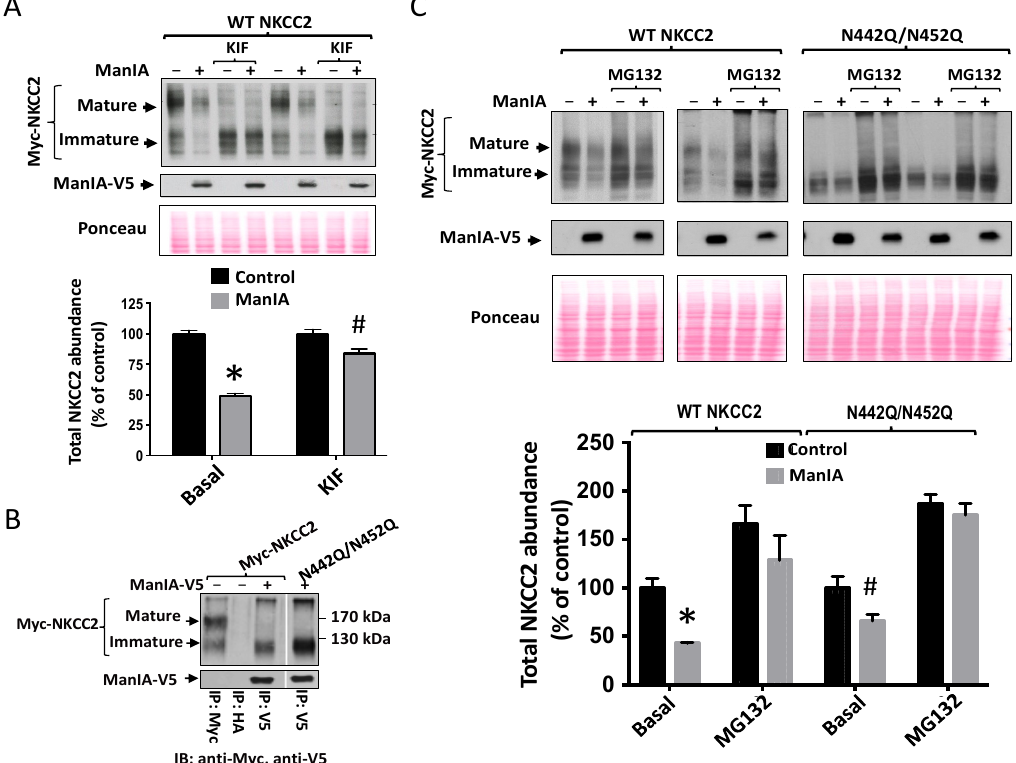
Figure 7. Role of mannose trimming in NKCC2 regulation by ManIA. ( A ) Effect the mannose trimming inhibitor kifunensine on ManIA-induced downregulation of NKCC2. 18 h post-transfection, OKP cells transiently transfected with Myc-NKCC2 alone or with ManIA-V5, were treated with 25 µ M of kifunensine (KIF) or without for 6 h prior to cell lysis. The cell lysates were subjected to SDS-PAGE and immunoblotted with anti-Myc and anti-V5 antibodies. Bottom , densitometric analysis of NKCC2 bands from untreated and treated cells with kifunensine (KIF). Data are expressed as percentage of control ± SE. *, p < 0.001, #, p < 0.02 versus control ( n = 4). ( B ) co-immunoprecipitation of ManIA with non-glycosylated NKCC2 (N442Q/N452Q). Cell lysates from cells transfected with WT NKCC2 or N442Q/N452Q in the presence or absence of ManIA-V5 were immunoprecipitated ( IP ) with anti-Myc or anti-V5 antibody. Similar to WT NKCC2, N442Q/N452Q protein co-immunoprecipitated with ManIA was detected by immunoblotting ( IB ) using anti-Myc ( lane 3 ). ( C ) Effect of ManIA on non-glycosylated NKCC2. HEK Cells were transfected with Myc-NKCC2 or N442Q/N452Q in the presence or absence of ManIA-V5. 18 h post-transfection, cells were treated with or without 10 µ M MG132 for 6 h prior to cell lysis as previously described [53,61]. Cell lysates were then subjected to immunoblotting analysis for Myc-NKCC2 and ManIA-V5. Lower panel , quantitation of steady-state total NKCC2 expression levels with or without ManIA co-expression. Data were normalized to the indicated loading control (Ponceau staining) from the same lane in each membrane and are expressed as percentage of control *, p < 0.004, #, p < 0.05 versus control ( n = 3).